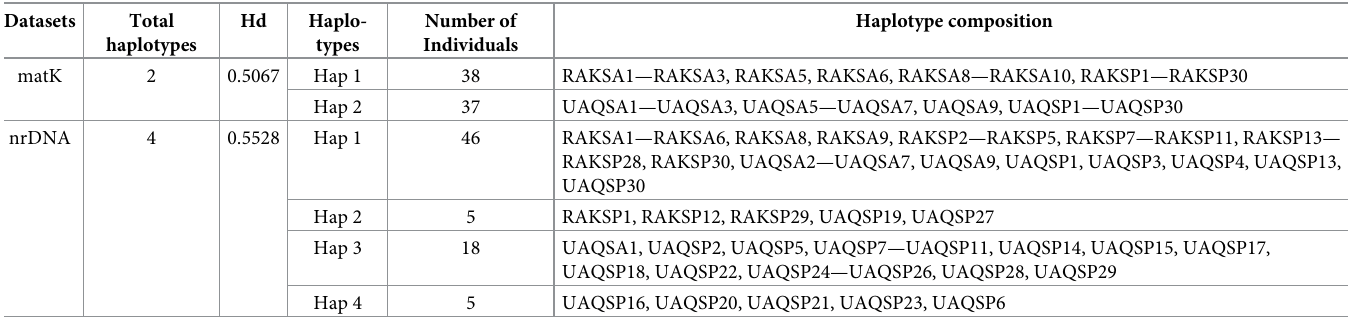
Table 2. Haplotype distribution of Salicornia persica belonging to matK and nrDNA datasets.